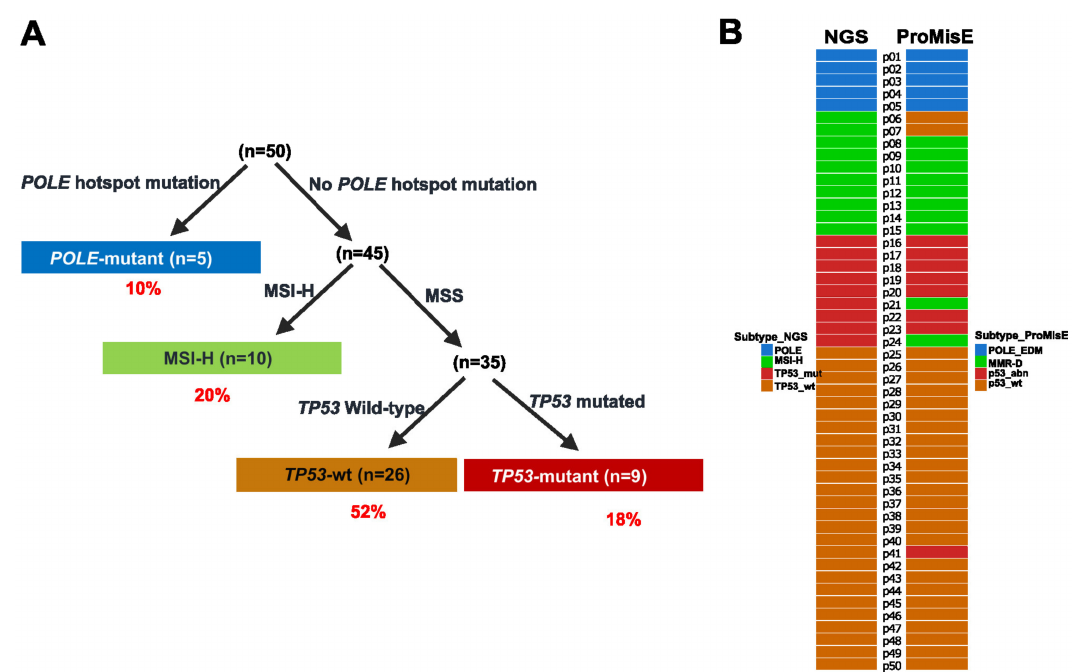
Figure 1. NGS one-stop molecular subtyping of 50 patients with endometrial cancer: ( A ) Flowchart of molecular subtyping of patients by NGS; ( B ) Comparison of classification between NGS strat- egy and IHC-based ProMisE approach. Abbreviation: MSI-H: microsatellite instability high; MSS: microsatellite stable; MMR-D: DNA mismatch repair